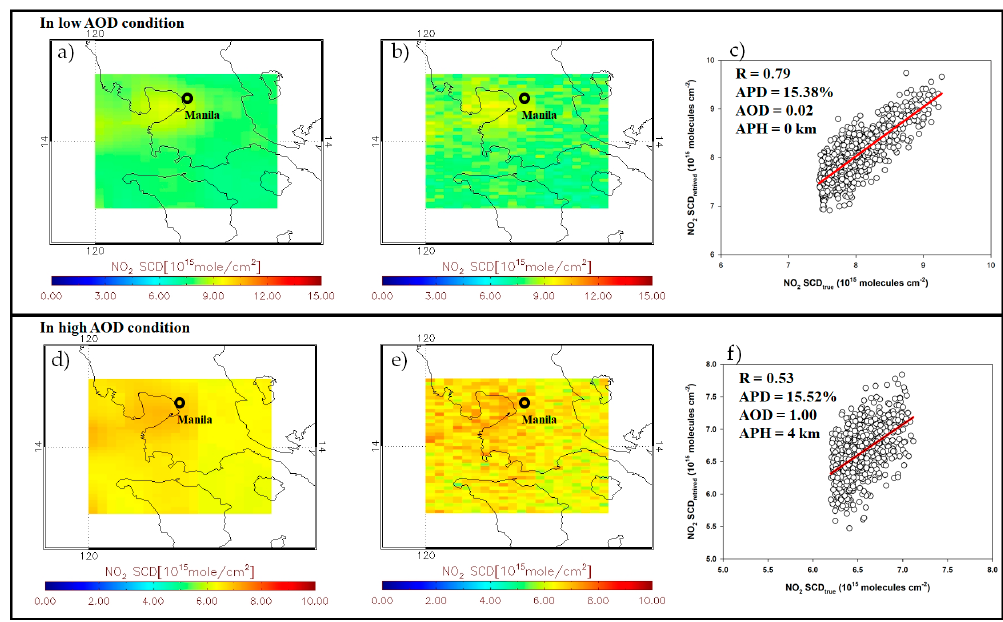
Figure 11. ( a ) True NO 2 SCDs, ( b ) retrieved NO 2 SCDs, and ( c ) a scatter plot of true and retrieved NO 2 SCDs in Manila in December 2011 under low-AOD conditions. Panels ( d – f ) are the same as ( a – c ) except under high-AOD conditions. (Slant column density (SCD) and aerosol optical depth (AOD)).